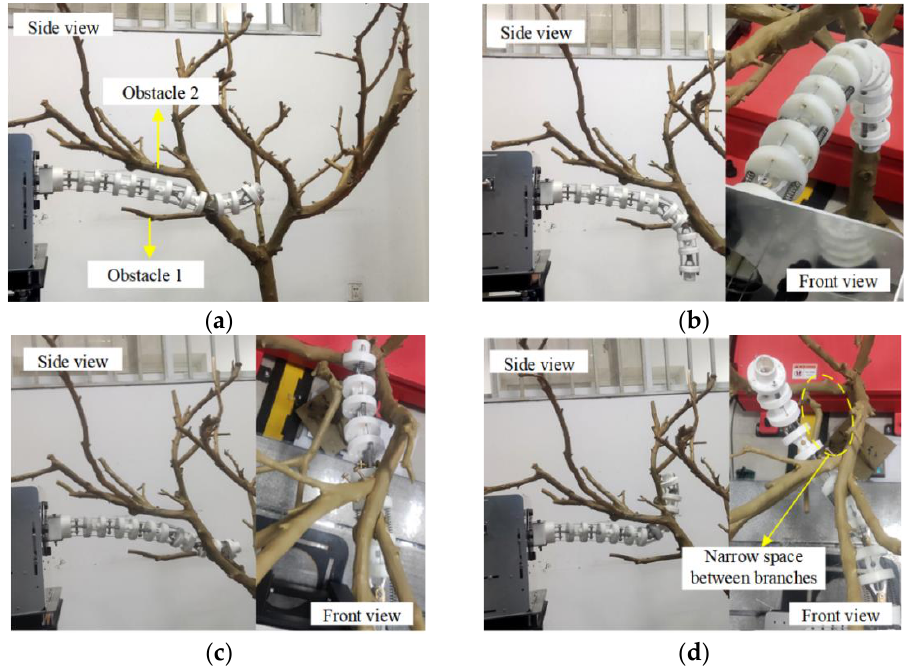
Figure 12. The operations in the narrow space between branches: ( a ) initial state; ( b ) intermediate